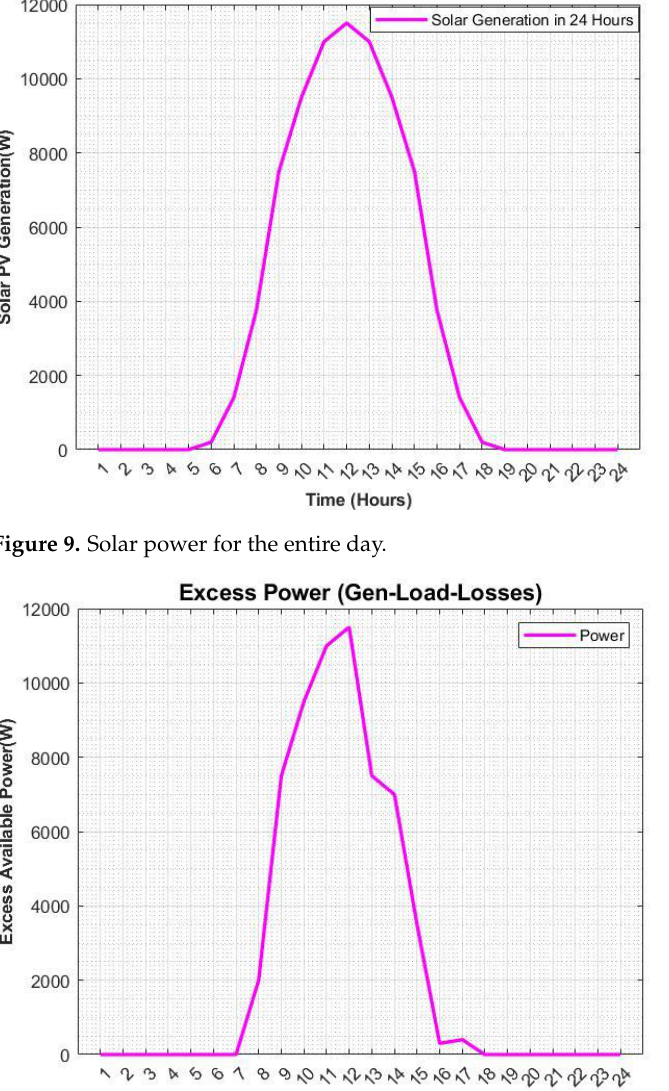
Figure 11. SoC of the battery.